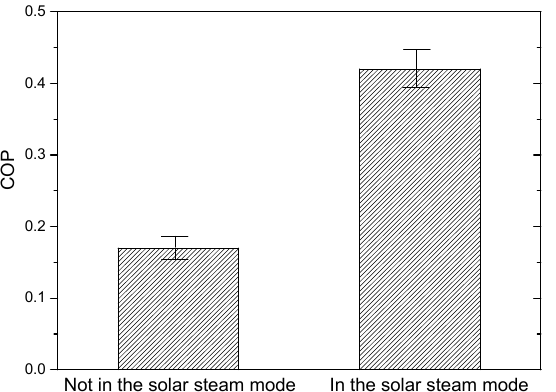
Figure 15. COP of evaporating pure water in different modes.